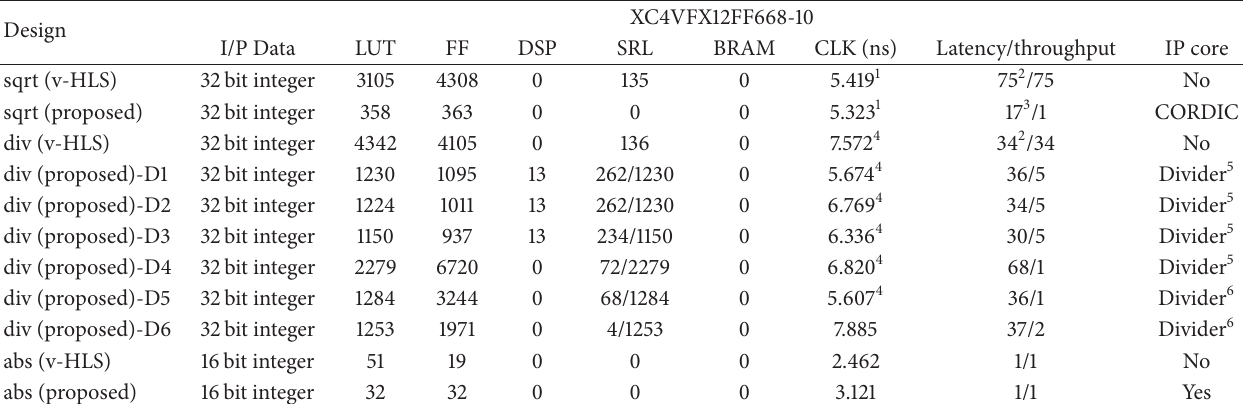
Table 7: Mapping of some representative in-built C functions.